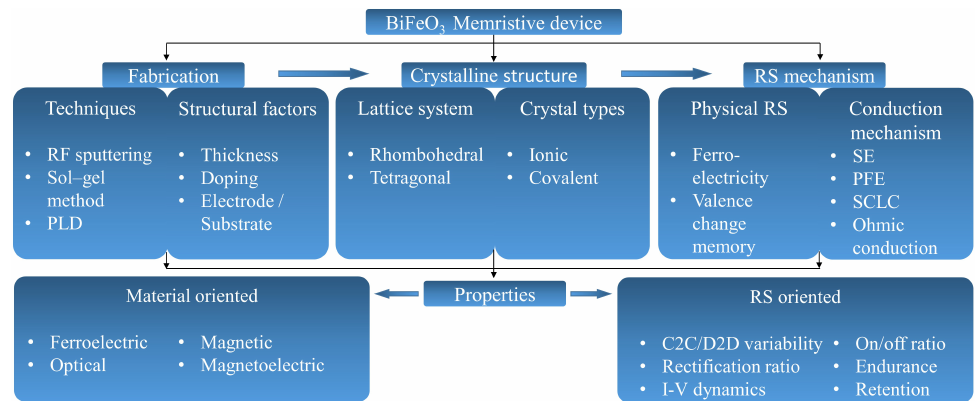
Figure 1. Schematic diagram of a BFO memristive device, briefly illustrating the key aspects of its common fabrication techniques, crystalline structures, RS mechanism, and various properties. (SE: Schottky emission, PFE: Poole–Frenkel emission, SCLC: space–charge-limited conduction, C2C: cycle to cycle, D2D: device to